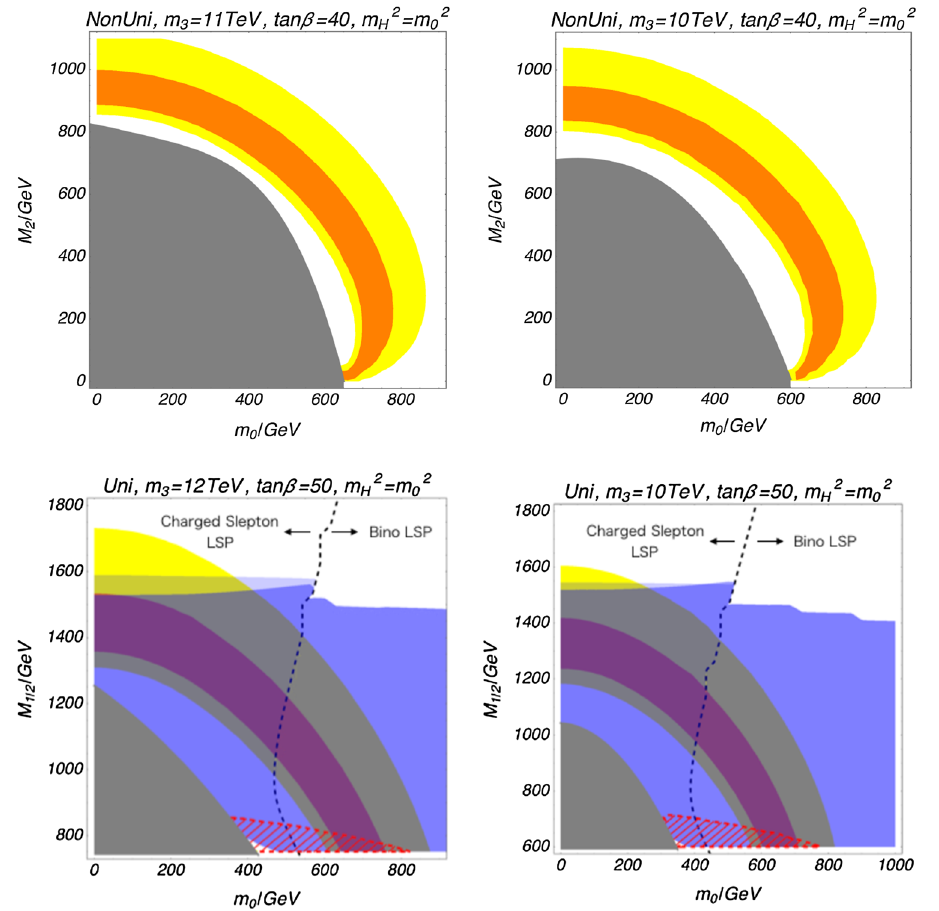
Fig. 2 The plots for the muon g − 2 on the ( m 0 − M 2 ) plane with the non-universal gaugino masses M 1 (cid:4) 1 . 7 M 2 at the GUT scale. We take M 1 = 1 . 725 × M 2 ( M 1 = 1 . 74 × M 2 ) and the gluino mass parameter M 3 = − 2 . 6TeV ( − 2 . 5TeV ) at the GUT scale for m 3 = 11TeV ( 10TeV ) . The color codes are the same as Fig. 1. The Higgs boson mass is consistent with the observed one in the favored regions